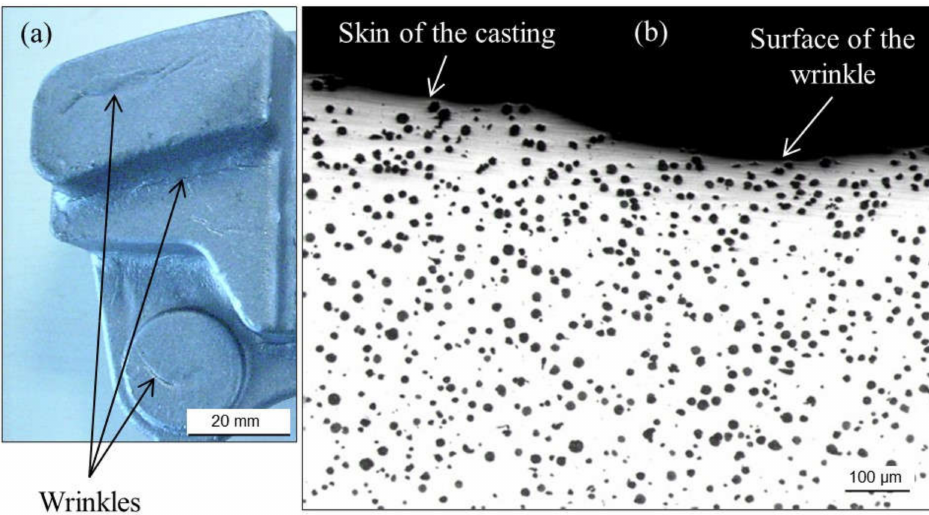
Figure 13. Macroscopic view of wrinkles at the surface of a ductile iron casting ( a ) and micrograph of a cross section showing the bottom of the wrinkle groove ( b